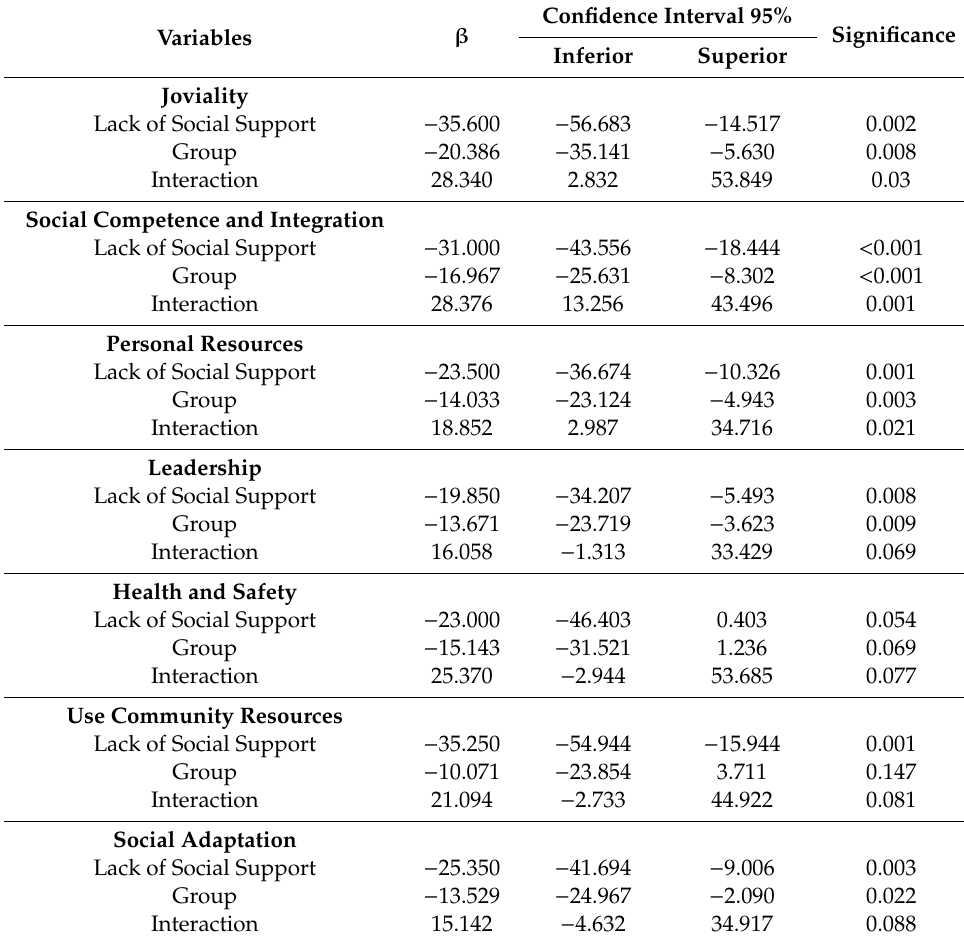
Table 6. Interaction of “Lack of Social Support” with Group on Joviality, Integration and Social Competence, Personal Resources, Leadership, Health and security, Social Life, and Social Adaptation. FXS = Fragile X Syndrome. CG = control group (central tendency and